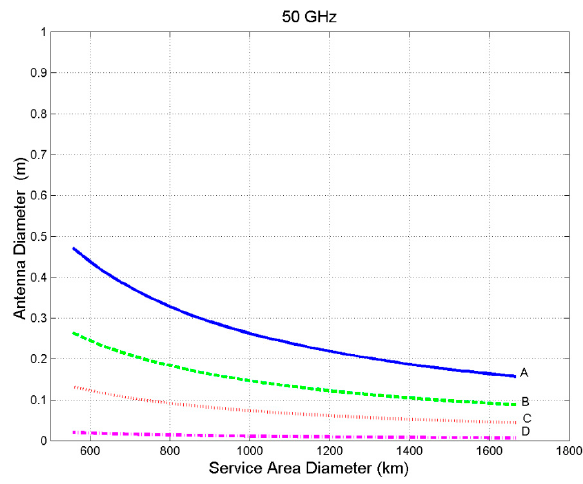
Figure 9. Antenna diameter as a function of the service area diameter, at 50 GHz for the GeoSurf constellation. A refers to h = 35,876 km; B to h = 20,000 km; C to h = 10,000 km, D to h = 1500 km.